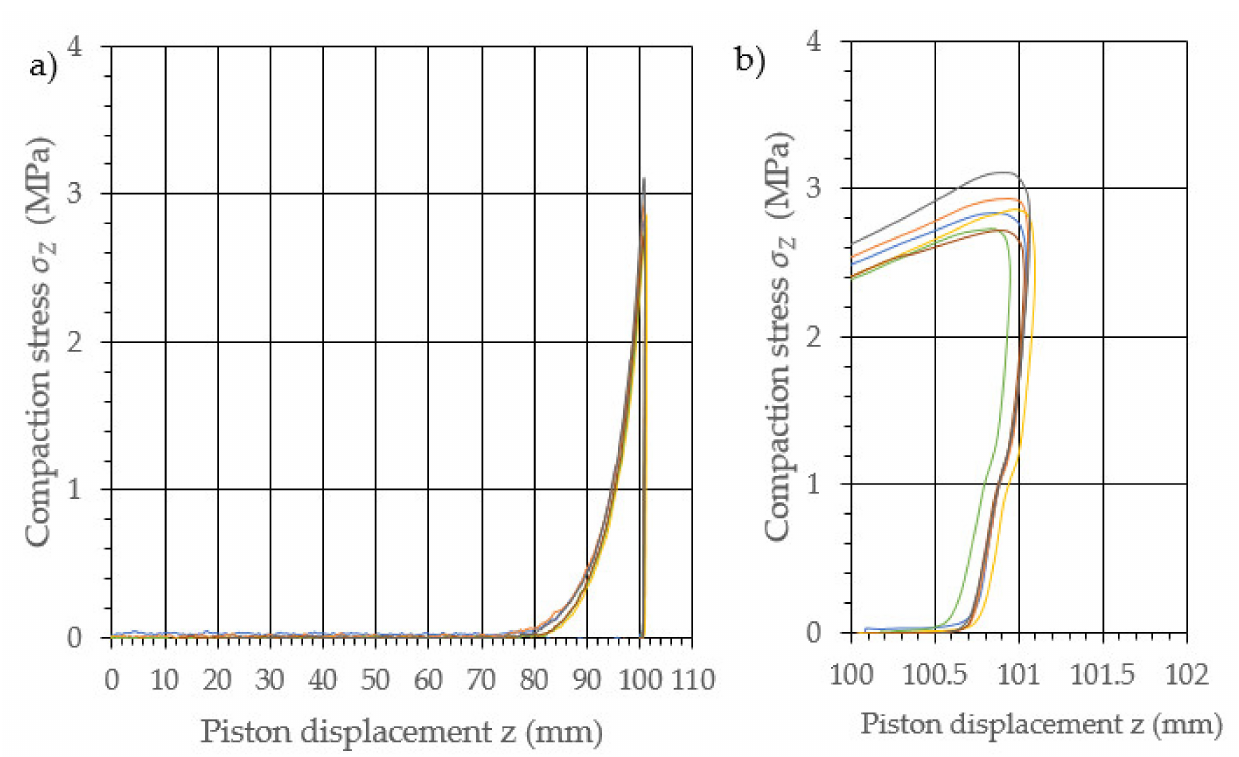
Figure 4. Characteristic curves for the compression with relaxation of dry ice with a final density of 1164.9 kg/m 3 . ( a ): The overall course of the characteristics; ( b ): an enlarged relaxation section of the compacted material.